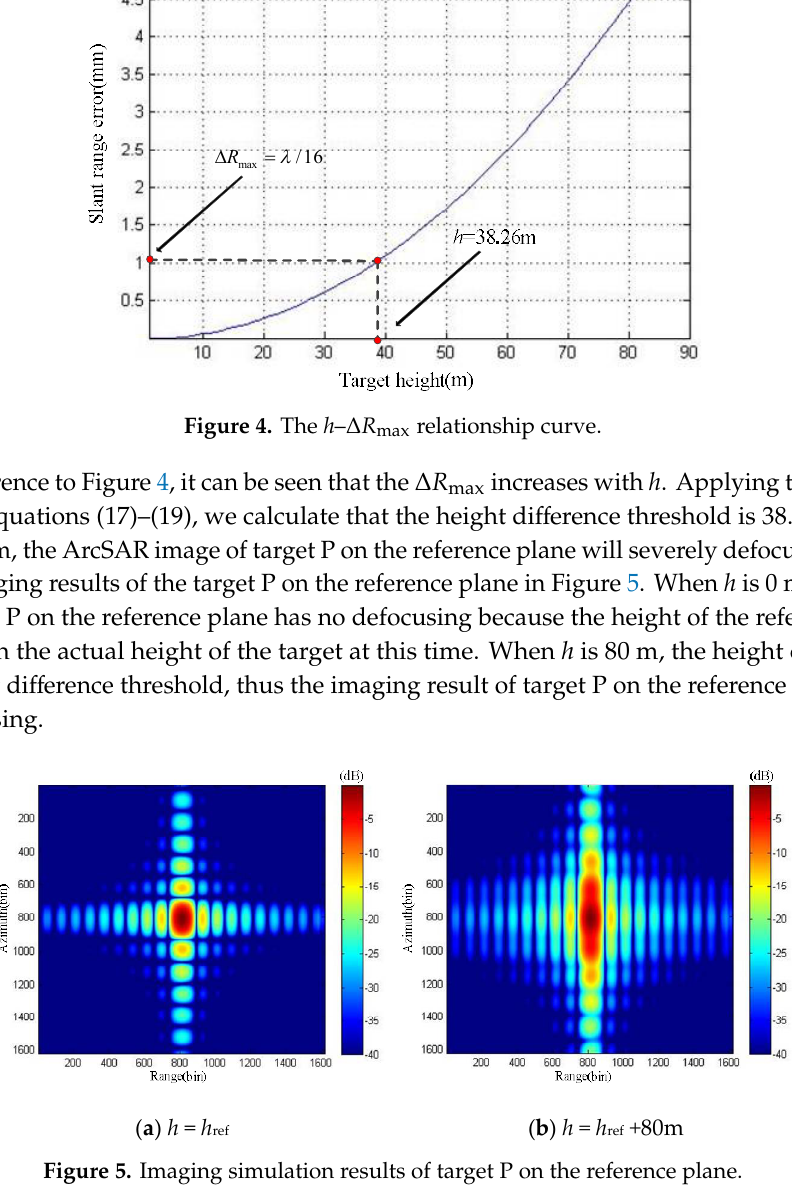
Figure 5. Imaging simulation results of target P on the reference plane.